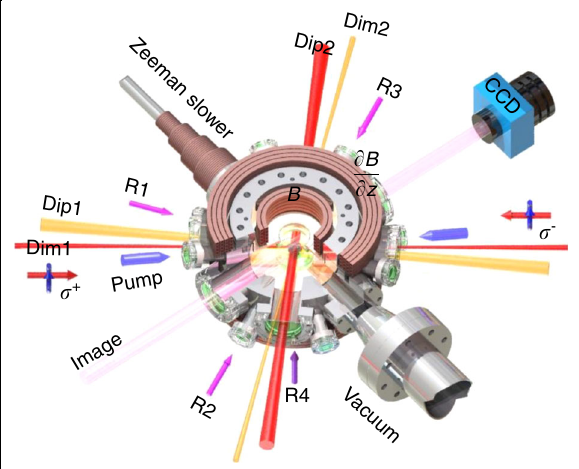
Fig. 1 Experimental setup. Four Raman lasers (R1-R4) are used for 3D degenerated Raman sideband cooling, in which the blue detuned pump lasers (pump) are used to polarize the atoms. The crossed dimple trap (Dim1 and Dim2) is overlapped with a magnetically levitated dipole trap (Dip1 and Dip2) for forming a combined optical trap. The hybrid evaporative cooling is implemented by reducing the magnetic fi eld gradient ∂ B/ ∂ z and lowering the powers of the optical trap lasers. A 133 Cs BEC is fi nally con fi ned in a quasi-1D optical trap composed of the lasers Dim1 and Dip2. The uniform magnetic fi eld B can be tuned to change the atomic interaction. The momentum-state lattice is formed by re fl ecting the dimple trap laser Dim1 to construct a series of Bragg transitions between discrete momentum